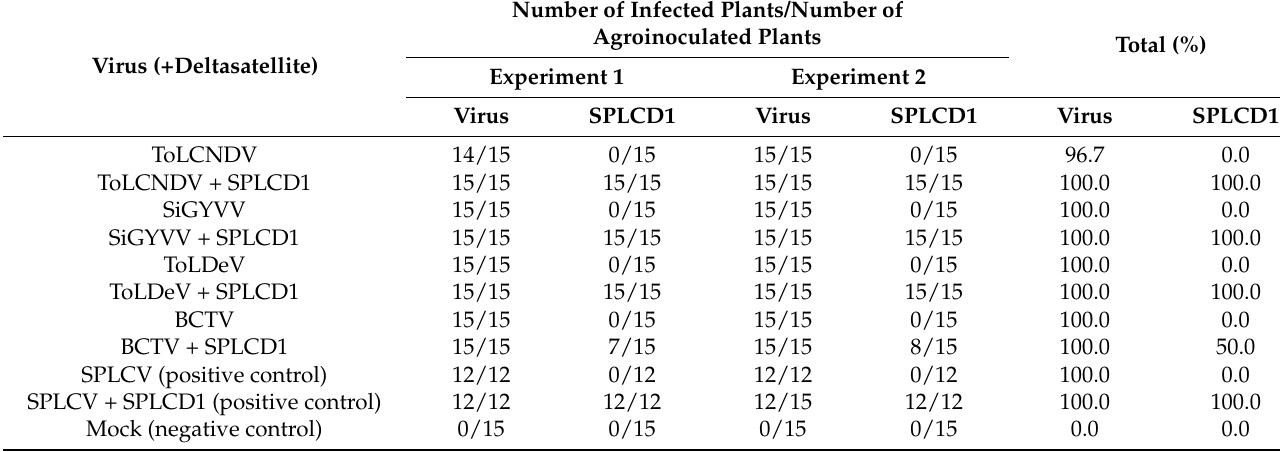
Table 2. Infectivity of sweet potato leaf curl deltasatellite 1 (SPLCD1) in the presence of various geminivirids in Nicotiana benthamiana